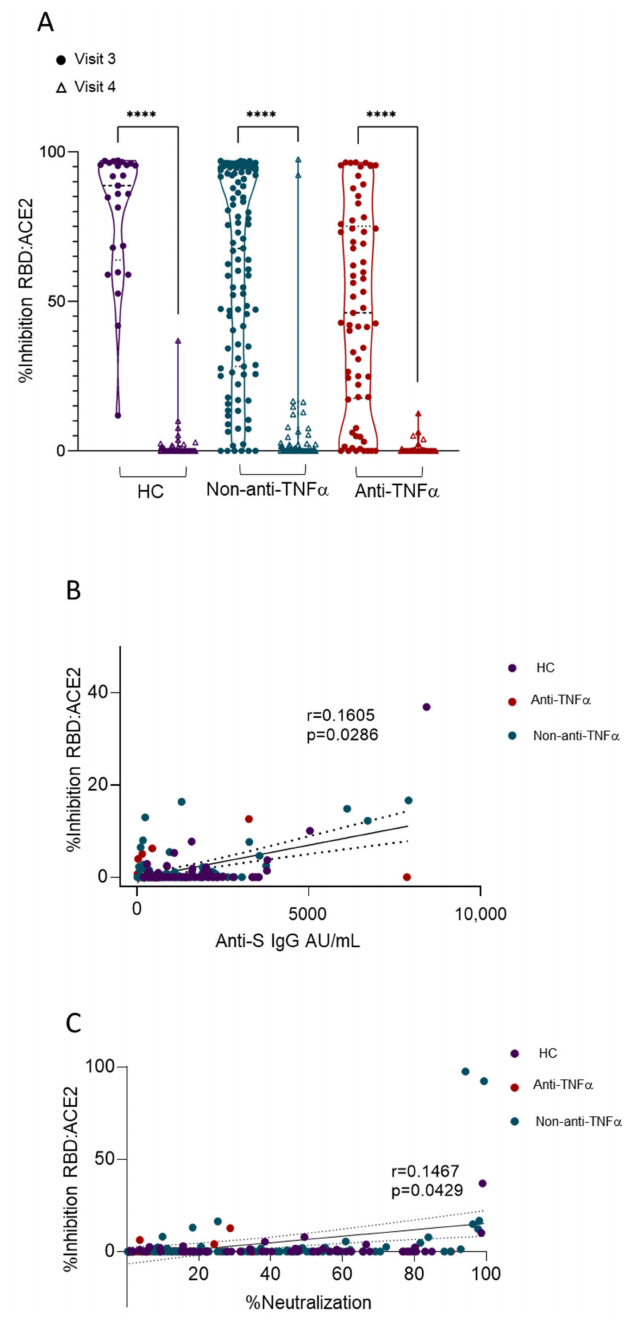
Figure 4. Significantly reduced levels of anti-SARS-CoV-2 inhibiting antibodies 6 months after two BNT162b2 vaccine doses in all recruited subjects. ( A ) Ability of serum from healthy controls (HCs, shown in purple), patients with IBD receiving non-anti-TNF α treatment (non-anti-TNF α , shown in blue) and patients with IBD receiving anti-TNF α treatment (anti-TNF α , shown in red) to inhibit SARS- CoV-2 RBD binding to ACE2 receptor. Values measured with ELISA and presented as % inhibition ( y axis). Visit 3 (filled circles), visit 4 (open triangles)—after two vaccine doses, 1 and 6 months, respectively. Zero inhibition was set as the value of RBD without added sera. Statistical analysis was carried out using independent sample Kruskal–Wallis test, ****— p < 0.0001. ( B ) Correlation between anti-S titer and inhibition responses. ( C ) Correlation between neutralizing activity and inhibition responses. Abbreviations: RBD—receptor-binding domain; ACE2—angiotensin-converting